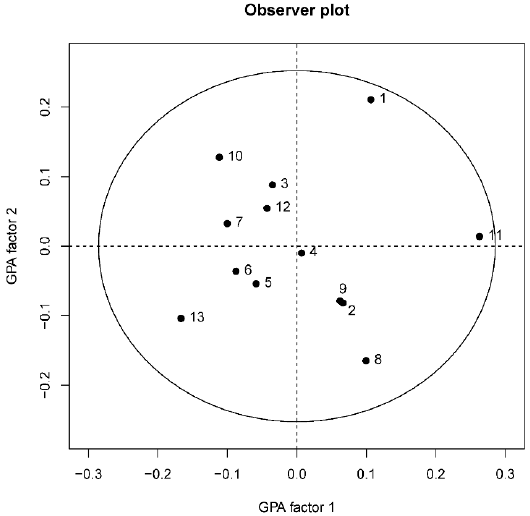
Figure 1. Observer plot shows the consensus among the 13 QBA assessors using the FCP methodology, the circle represents within the 95% confidence region.